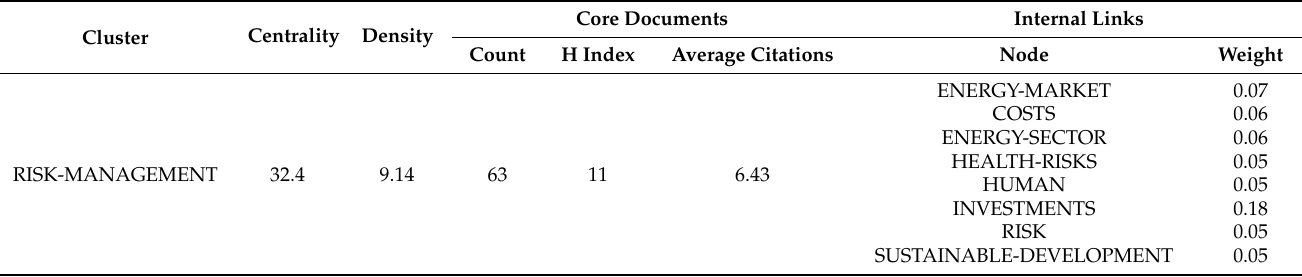
Figure 9. Major theme ( a ) and thematic network ( b ) of the fifth sub-period (2021–2022). Note: Clusters information: RISK-MANAGEMENT (centrality: 32.4; density: 9.14); RENEWABLE-ENERGY (centrality: 0.95; density: 13.89); CORONAVIRUS (centrality: 5.69; density: 25); DECISION-SUPPORT (centrality: 0.79; density: 16.67); ENERGY-TRANSITIONS (centrality: 0.56; density: 13.33); GASES (centrality: 1.16; density: 13.33). Node size is proportional to the number of papers; the number in a node denotes the number of papers related to a node topic. See Section 2.2 for description of the quadrants. Table 8. Cluster information and key parameters—sub-period (2021–2022).